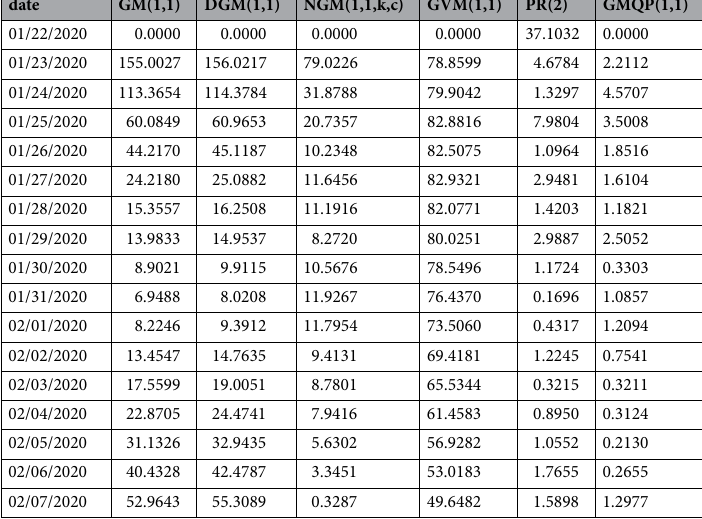
Table 13. The Errors of different model in the death cases of COVID-19 of China, (%).